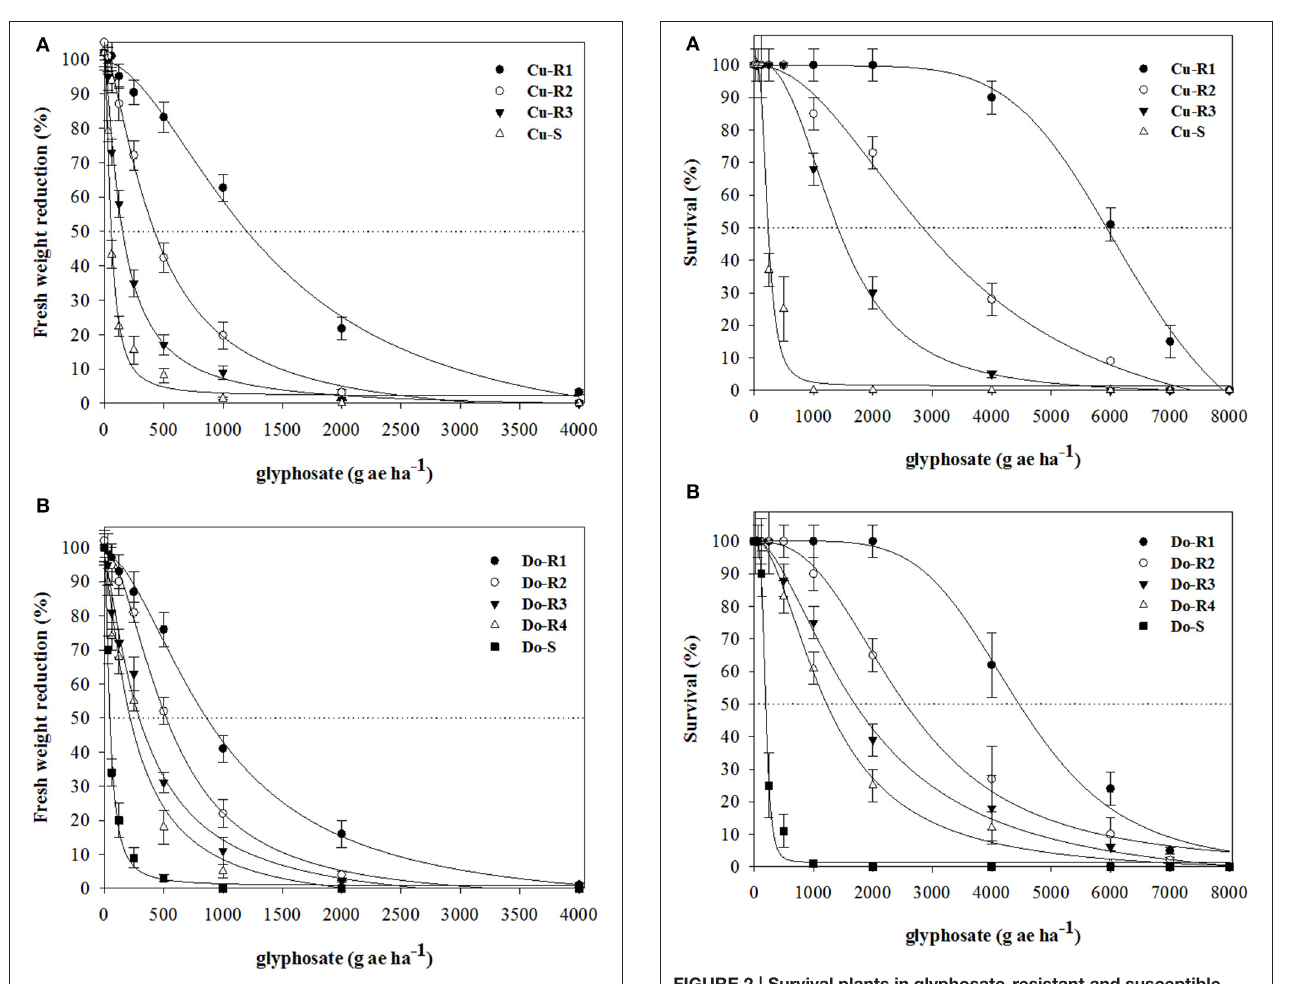
FIGURE 1 | Shoot biomass in glyphosate-resistant and susceptible P. hystherophorus accessions from Cuba (A) and Dominican Republic (B) 30 days after treatment. Symbols denoted mean ( n = 10) ± standard errors of the mean.